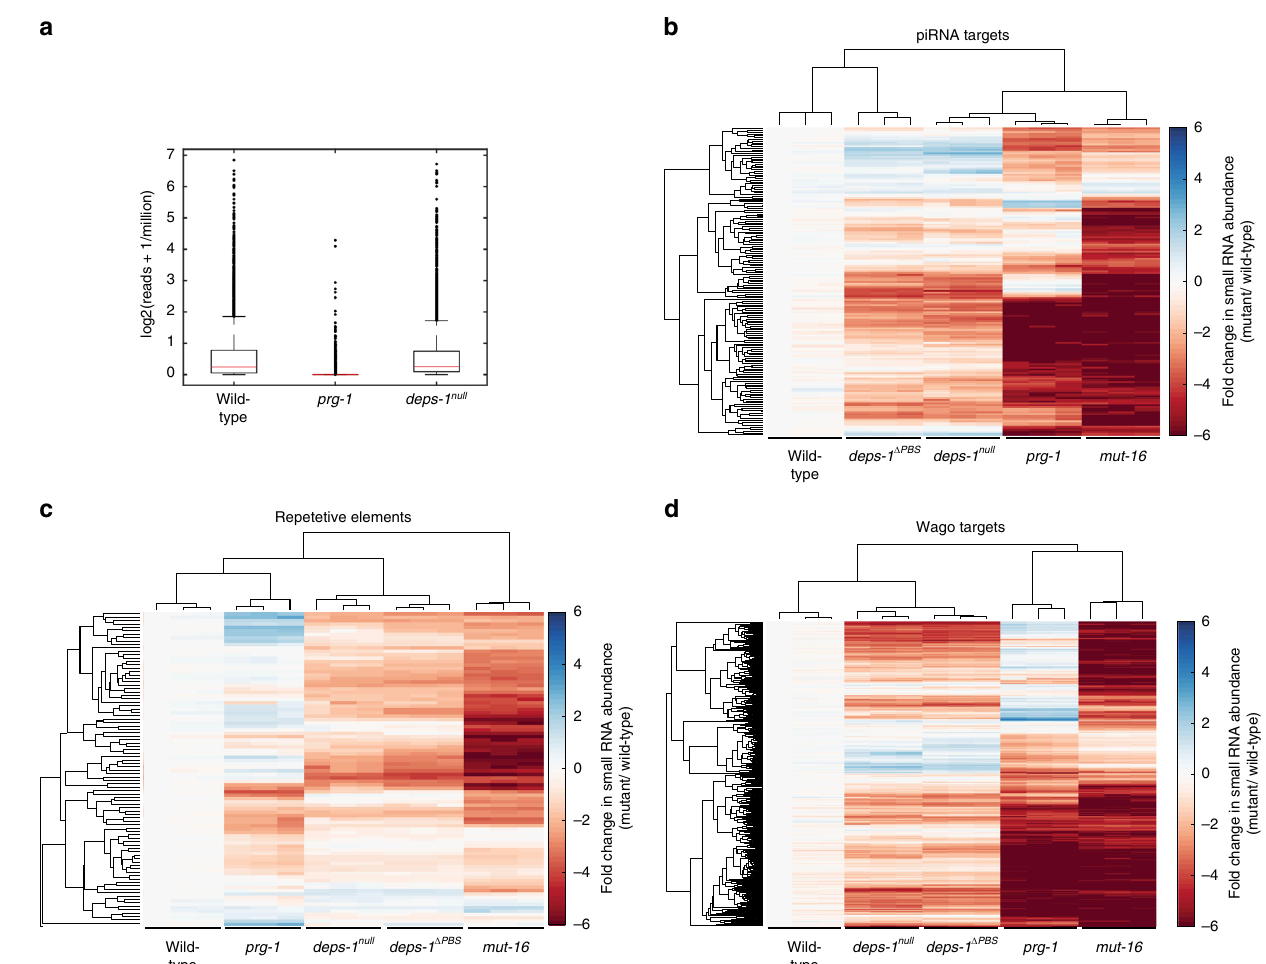
Fig. 4 deps-1 regulates 22Gs against piRNA targets and other endo-siRNAs. a Small RNAs were sequenced in animals containing piRNA sensor ( mjIs144 ; denoted as wild-type) alone, or in the presence of deps-1(bn124) or prg-1(n4357) mutations. deps-1 mutant expresses similar level of 21Us as in wild-type animals, whereas 21Us in prg-1(n4357) mutant is signi fi cantly diminished compared with wild type and deps-1 mutant (one-sided t -test, p value < 10 − 20 ). n = 2 biologically independent samples. Centre line indicates the median, outer boxes represent the 25th and 75th percentiles, whiskers indicate the distance 1.5 times distance between the 25th and 75th percentiles or are limited to the most extreme observation. Outliers are marked if they are greater or less than the whiskers. Cluster analysis of 5 ’ -independent small RNA libraries showing the fold change of small RNAs mapped to known targets of different small RNA pathways: piRNA targets ( b ), repetitive elements ( c ) and wago targets ( d ), in the indicated mutants compared to wild type. Wild-type denotes animals expressing piRNA sensor ( mjIs144); deps-1 null denotes animals expressing deps-1(bn121) ; piRNA sensor ( mjIs144); deps-1 Δ PBS denotes animals expressing deps-1 Δ PBS (mj605); mut-16(pk710); mut-16::gfp(mgSi2); mut-16 denotes animals expressing mut-16 (pk710); piRNA sensor ( mjIs144) . Fold change is displayed in natural log. n = 3 biologically independent samples. Source data are provided as a Source Data fi Test: p < 10 − 06 ; Fig. 4c and Supplementary Fig. 6c). deps-1 also affects wago targets 44 (300 out of 425 wago targets show > twofold reduction in 22Gs level in deps-1 mutant; Hypergeometric Test: p < 10 − 139 ; Fig. 4d and Supplementary Fig. 6d). However, unlike mut-16 in which 22 out of 23 ergo-1 targeting 22Gs have > two- fold reduction (Hypergeometric Test: p < 10 − 08 ), deps-1 has limited effects on ergo-1 targets 45 (7 out of 23 genes; Hypergeo- metric Test: p < 0.2; Supplementary Fig. 6e). Lastly, deps-1 does not affect the 22Gs of csr-1 targets because we observed a sig- ni fi cant reduction in the number of overlapping genes between the csr-1 targets 46,47 (4 out of 162 genes) and genes with >twofold reduction in secondary siRNA levels in deps-1 mutants (447 out of 2012 genes; Hypergeometric Test: p < 10 − 13 ; Supplementary Fig. 6f). Therefore deps-1 functions in multiple (but not all) germline small RNA pathways which suggests the possibility that deps-1 might interact with other Ago proteins.